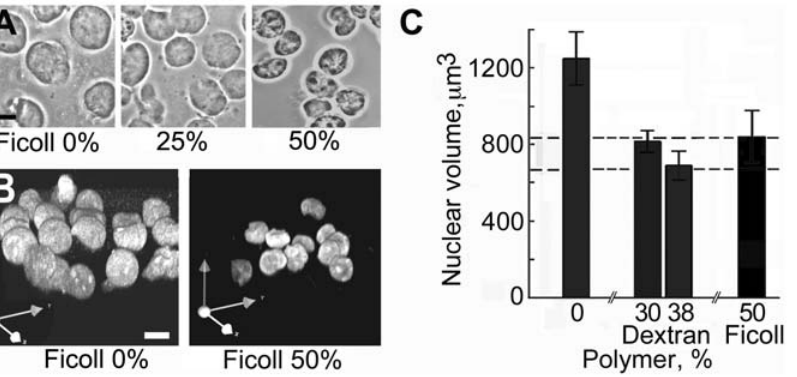
Figure 2. Influence of the concentration of polymer in the medium on nuclear volume. Nuclei were released as described in Figure 1, centrifuged onto slides, incubated for 30 min in a solution of the same polymer at the concentration shown, and fixed in the same solution. (A) nuclei in Ficoll, phase-contrast. (B) nuclei in Ficoll stained with YOYO, 3D volumes rendered from serial confocal sections to confirm that the changes of diameter in (A) represent changes of volume. (C) mean nuclear volume as a function of polymer concentration. Error bars show 95% confidence limits (n=30) and horizontal dashed lines 95% confidence limits for the volume of nuclei in living cells labelled with DRAQ5. All differences of mean volume from that in 0% polymer were significant at p # 0.01, calculated by the Welch t-test. Bars 10 m m.